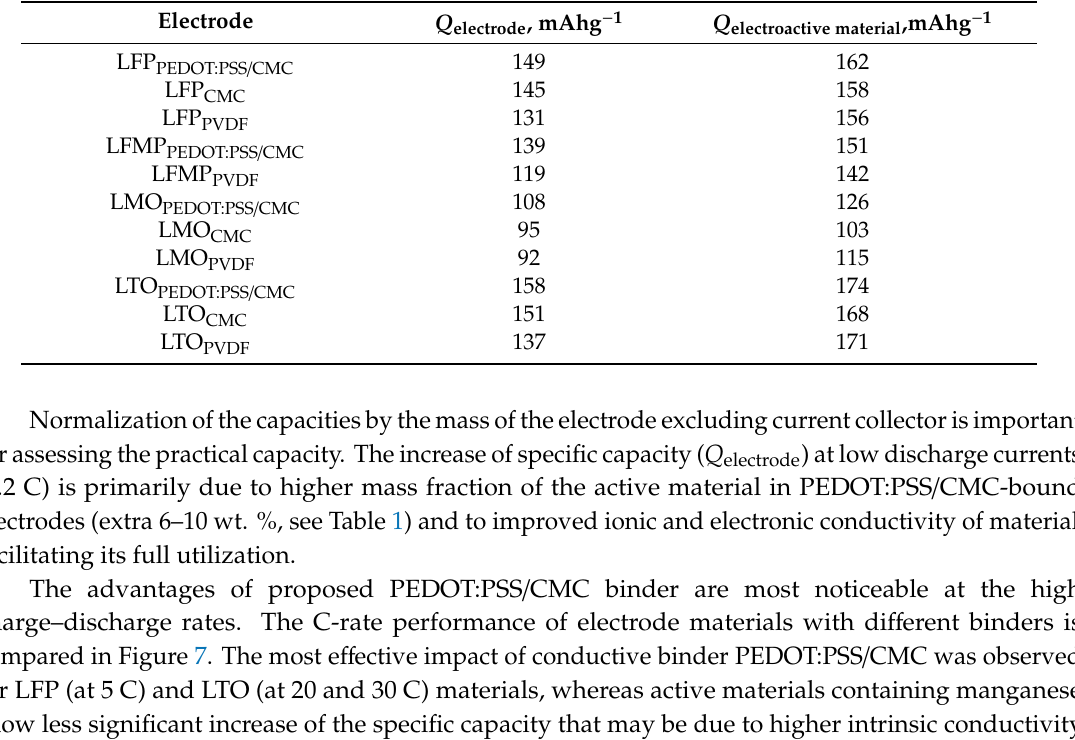
Table 2. Specific capacities of electrodes with three binders (PEDOT:PSS / CMC, CMC, and PVDF) at 0.2